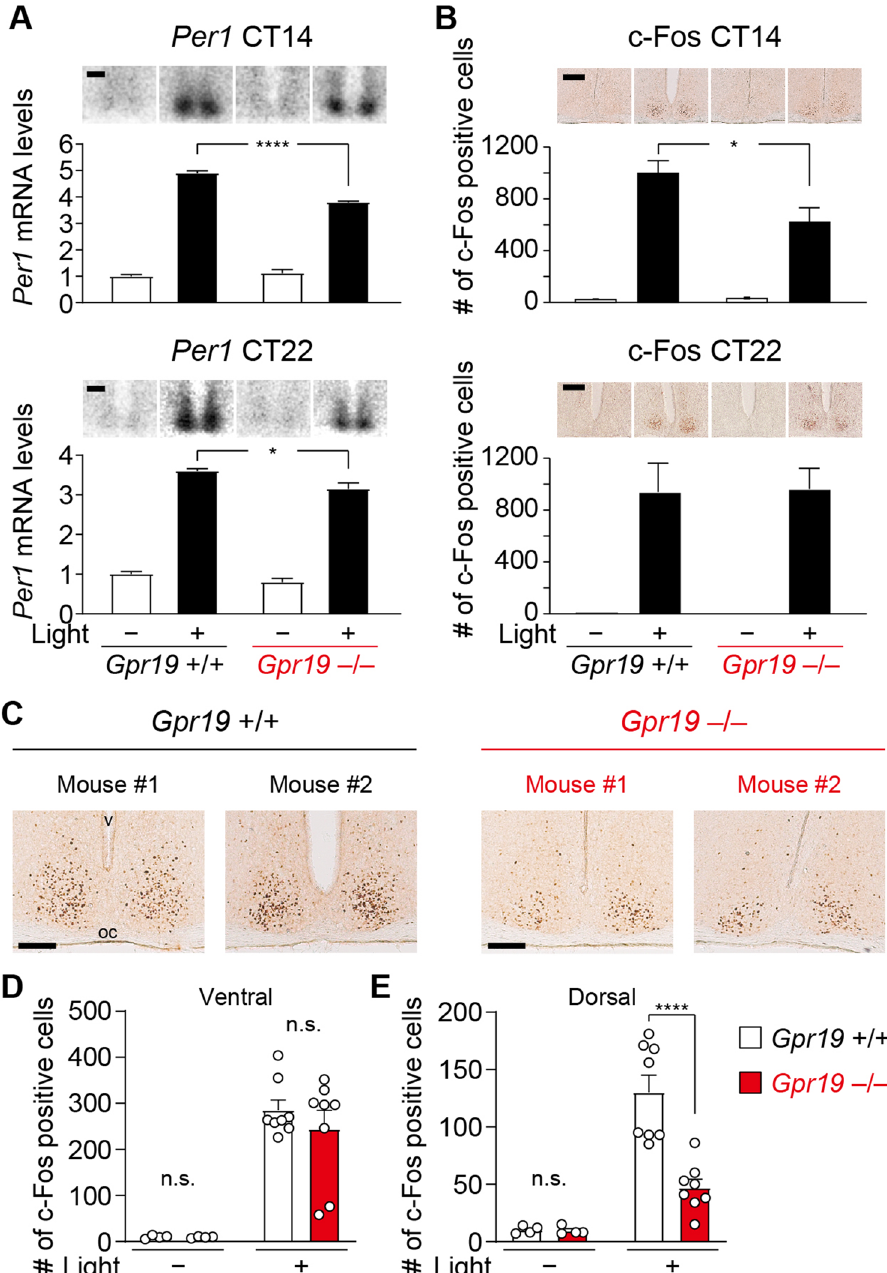
Figure 5. Attenuated light-induced induction of Per1 mRNA and c-Fos immunoreactivity in the SCN of Gpr19 −/− mice. ( A ) Per1 expression in the SCN of Gpr19 +/+ and Gpr19 –/– mice with or without a 15-min light pulse exposure at CT14 or CT22. Mice were sacrificed 1 h after light onset. Data are presented as the mean ± SEM ( n = 4). The mean value in Gpr19 +/+ SCN without a light pulse was set to 1. **** P < 0.0001, * P < 0.05, two-way ANOVA with Bonferroni’s post hoc test. Representative autoradiographs are shown on the top. Scale bars, 200 μm. ( B ) The number of c-Fos-immunopositive cells in the SCN of Gpr19 +/+ and Gpr19 –/– mice. Mice were illuminated as described in ( A ). Data are the mean ± SEM ( n = 4 for light ( −), n = 6–8 for light ( +)). * P < 0.05, two-way ANOVA with Bonferroni’s post hoc test. Representative images of immunohistochemistry are shown on the top. Scale bars, 200 μm. ( C ) Reduced c-Fos induction in the dorsal area of the SCN in Gpr19 –/– mice. Representative images of immunohistological distribution of c-Fos expression in the SCN of Gpr19 +/+ and Gpr19 –/– mice (2 mice for each genotype) after a 15-min light pulse exposure at CT14. oc, optic chiasm; v, third ventricle. Scale bars, 200 μm. ( D , E ) The number of c-Fos-immunopositive cells in the ventral ( D ) and dorsal ( E ) area of the SCN in ( C ) ( n = 4 for light ( −), n = 8 for light ( +)). Values are the mean ± SEM. **** P < 0.0001, two- way ANOVA with Bonferroni’s post hoc test. n.s., not